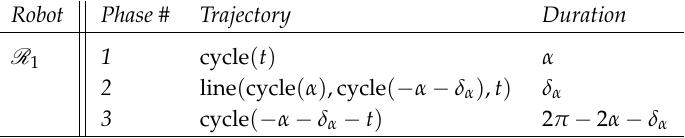
( α , B ) . The red point is ( Avg ( B 0